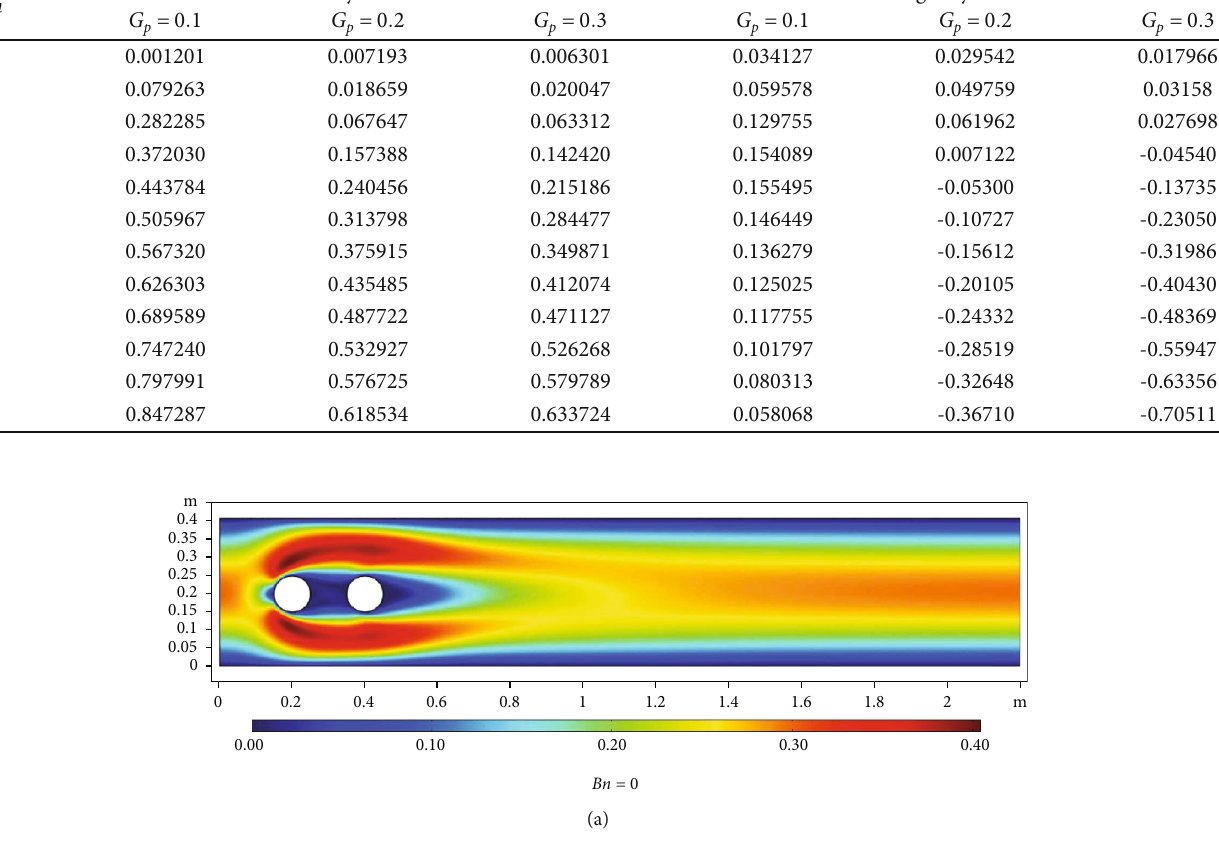
Table 3: In fl uence of Bn and separation distance on lift coe ffi cient C